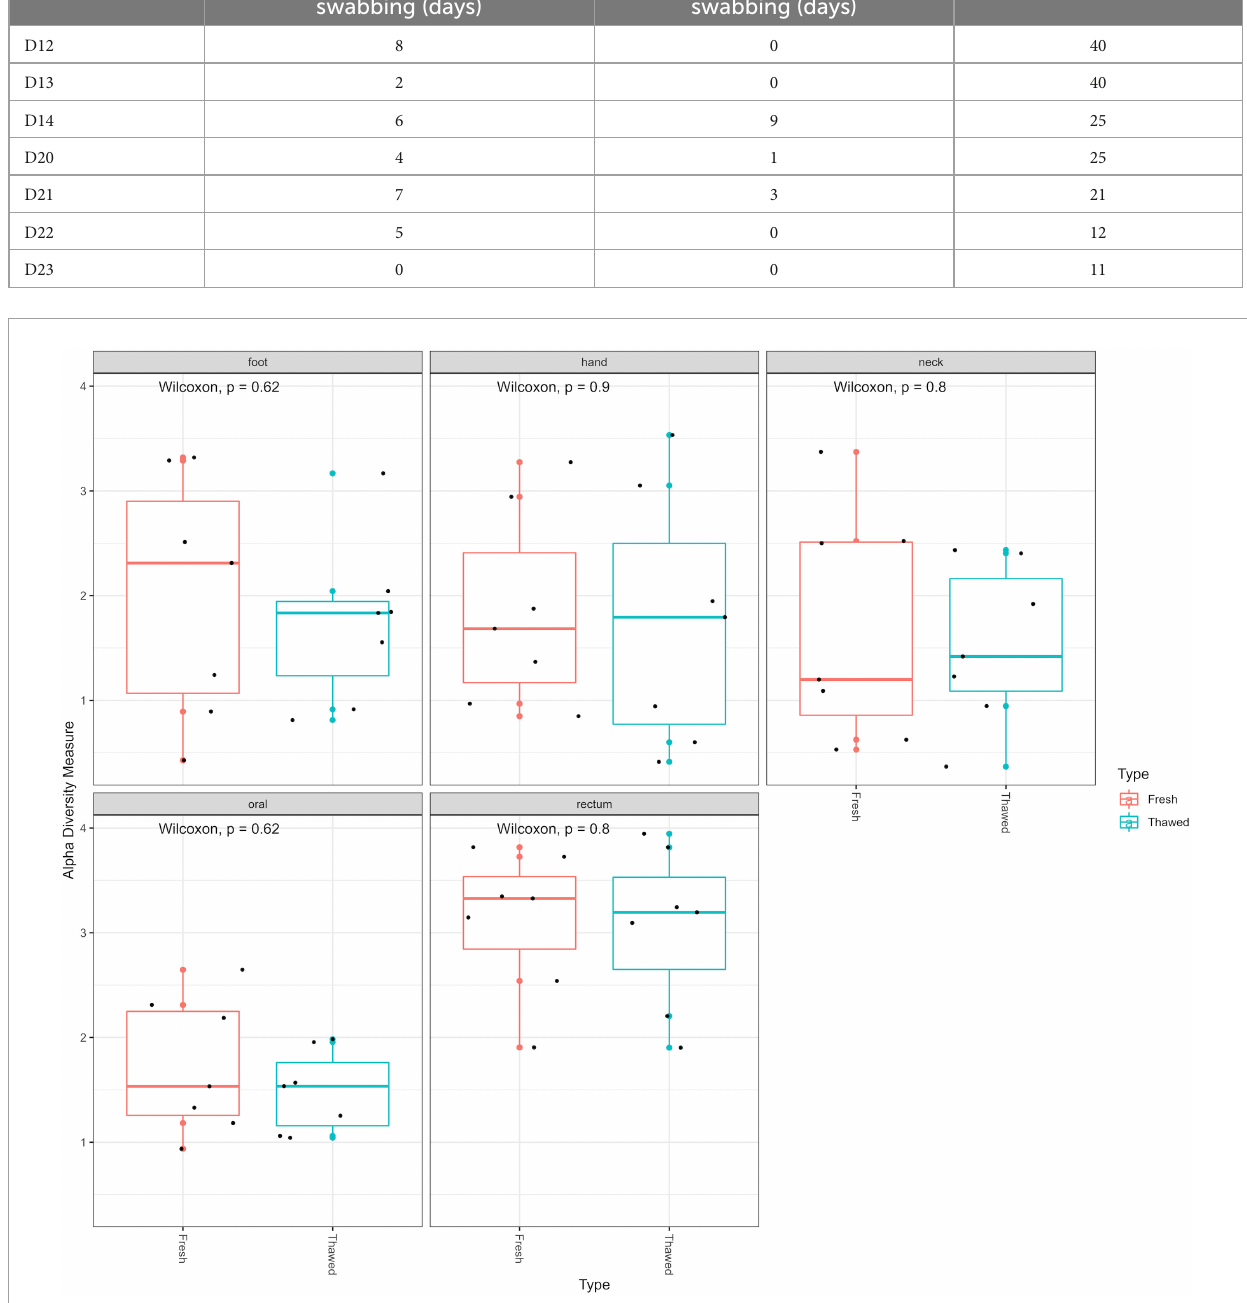
TABLE 1 Duration of refrigeration (+4 ◦ C) between arrival to the facility and swabbing, between swabbing and freezing of the donors, and duration of freezing ( − 20 ◦ C) of the donors. Donor ID